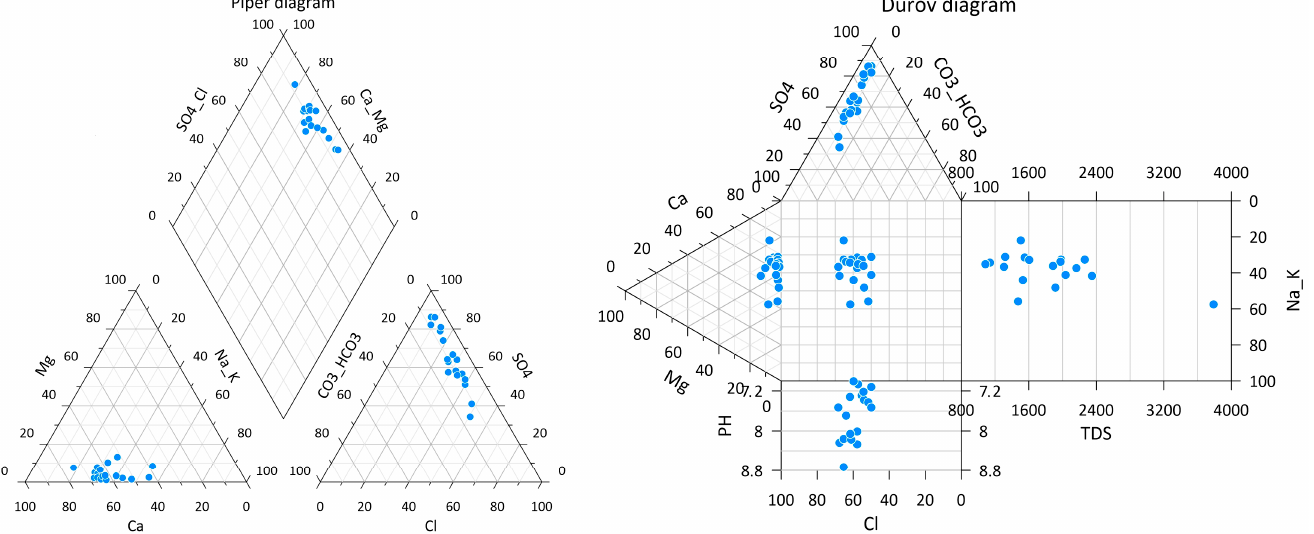
Figure 9. Piper and Durov diagrams for anion and cation composition of groundwater in 2018 and 2019.